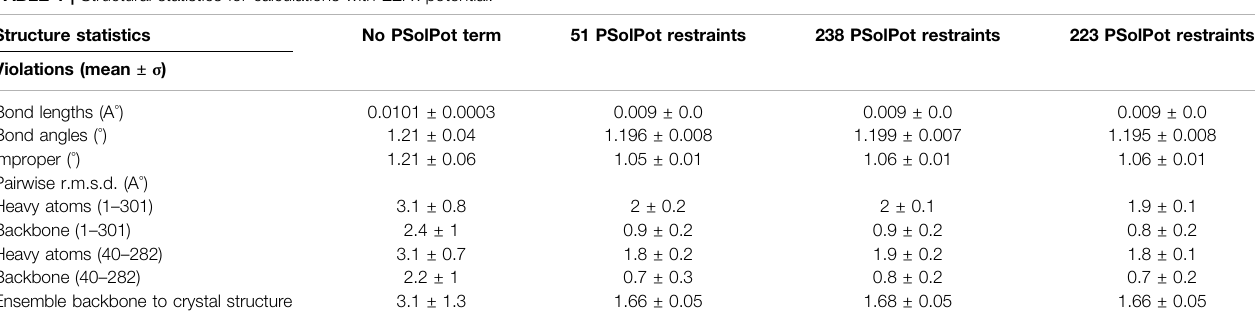
TABLE 1 | Structural statistics for calculations with EEFx potential.